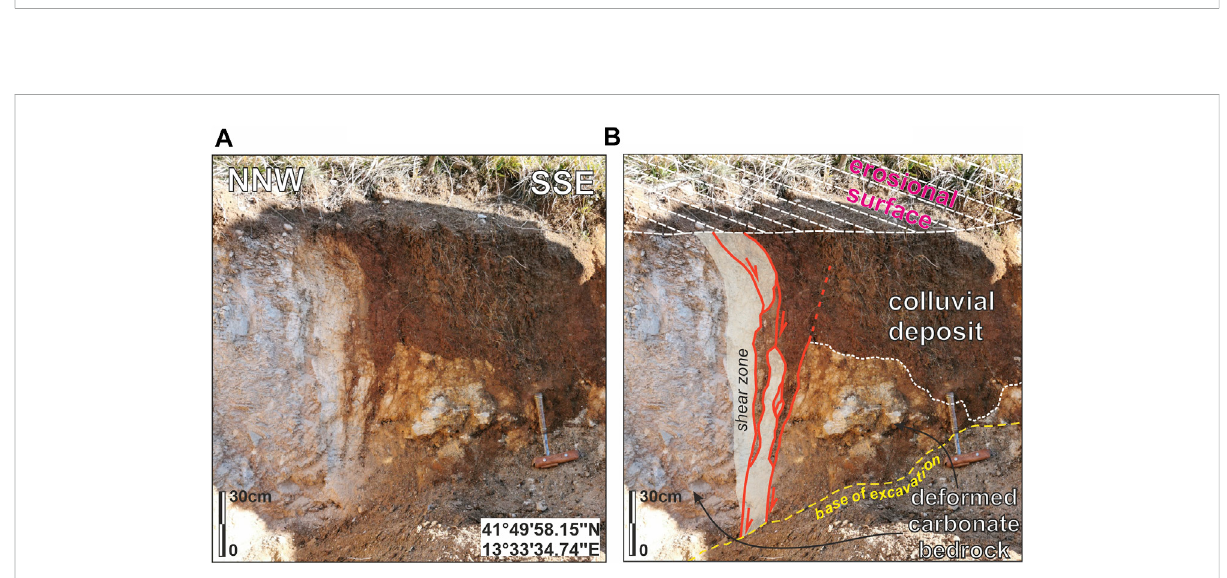
FIGURE 11 (A) Wall of the excavation made at the “ Cornarello ” site. (B) Stratigraphic scheme of the excavation